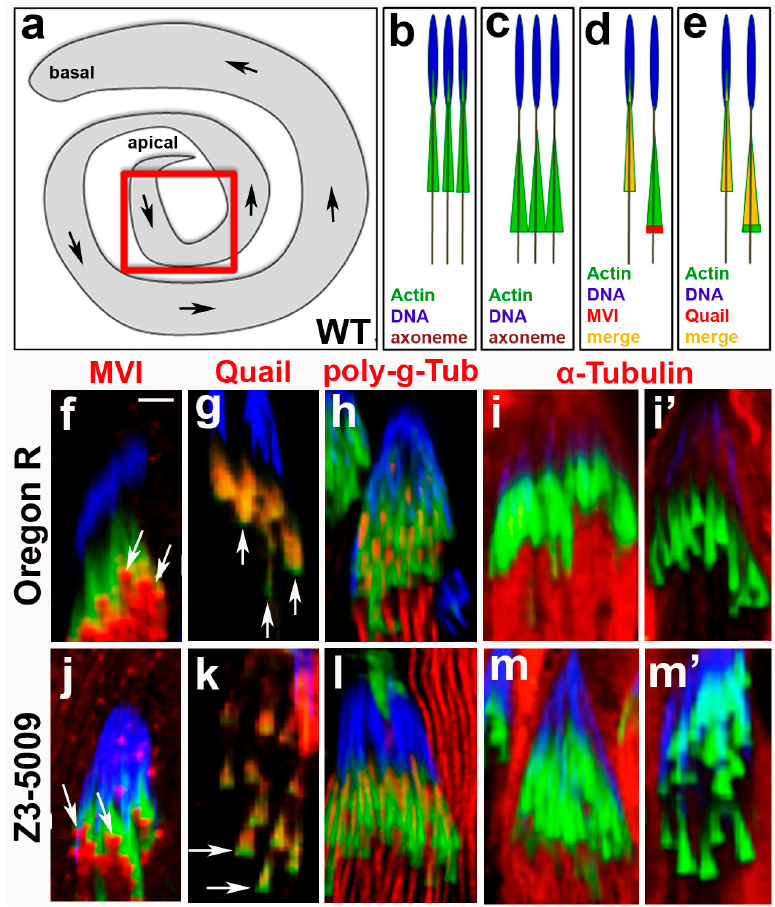
Figure 3. Immunocytochemical characterization of Z3-5009 mutant. Schematic representations of: whole Drosophila testis ( a ), newly forming actin cones in association with spermatid nuclei ( b ), early actin cones that have just moved a little away from the nuclei ( c ), myosin VI localization in newly forming/early control (WT Oregon R) cones ( d ), and quail localization in newly forming/early control cones ( e ); red box in ( a ) shows area-of-interest for all of the images in this figure, arrows in ( a ) indicate the direction of actin cones movement during spermatid individualization. Immunofluorescence comparative analysis of localization of selected proteins in control ( f – i’ ) and Z3-5009 ( j – m’ ) actin cones; phalloidin staining, green; antibody of interest, red; merge, yellow ; DAPI staining, blue. Myosin VI localizes to the front of conical actin cones in Z3-5009 mutant (( j ), arrows), consistent with the same-stage Oregon R cones (( f ), arrows). Actin-binding quail appears to proceed towards the rear domains of the control ( g ) and Z3-5009 ( k ) cones as seen by red staining, leaving more intense actin (green) areas in the front of the cones (arrows in ( g , k )). Spermatid axonemes are highlighted by poly-glycylated tubulin ( h , l ) and axoneme organization is normal in the Z3-5009 mutant ( l ) if compared to Oregon R ( h ). Alpha-tubulin appears to degrade to a similar extent in the same-stage Oregon R (( i’ ) vs. ( i )) and Z3-5009 (( m’ ) vs. ( m )) actin cones. Bar 5 µm.